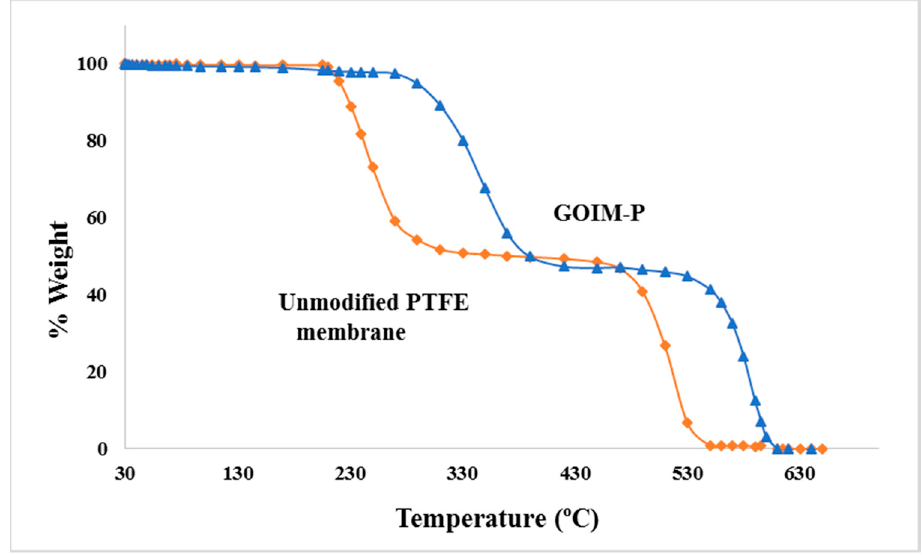
Figure 4. Thermal gravitational analysis (TGA) curves of unmodified and GOIM-P.